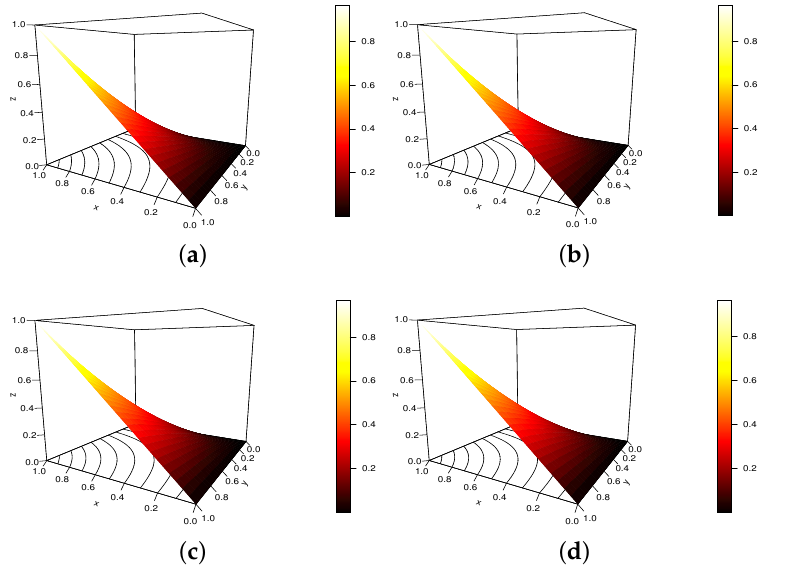
Figure 3. Display of the S copula for α = 0.049, γ = 1, and ( a ) β = π /2, ( b ) β = 2 π , ( c ) β = 3 π and ( d ) β = 4 π .